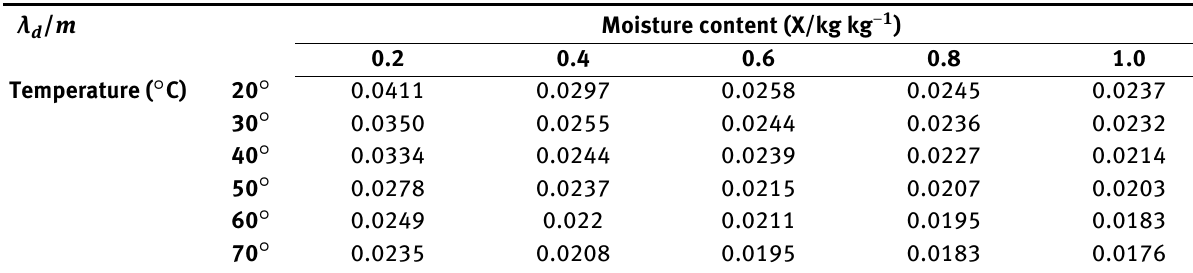
Table 3: The microwave length in paracetamol at temperatures between 20 and 70 ∘ C and in the moisture contents range of 0.2–1 kg kg −1 (2450